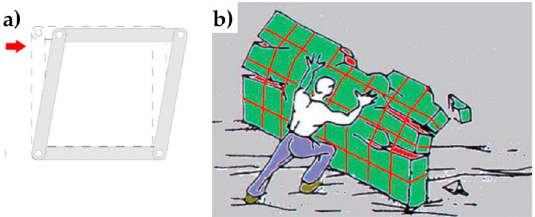
Figure 32. a ) Hinged mechanism between the ribbons of the rectangular arrangement of the CAM system; b ) Out ‐ of ‐ plane loading of a wall reinforced by the CAM system [52].